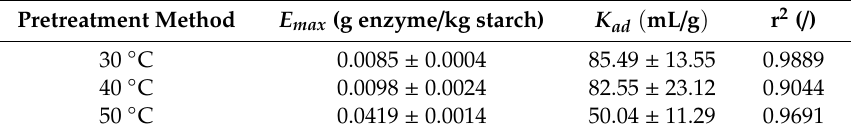
Table 2. Adsorption parameters of amylases on cassava flour fitted to the Langmuir model. Pretreatment